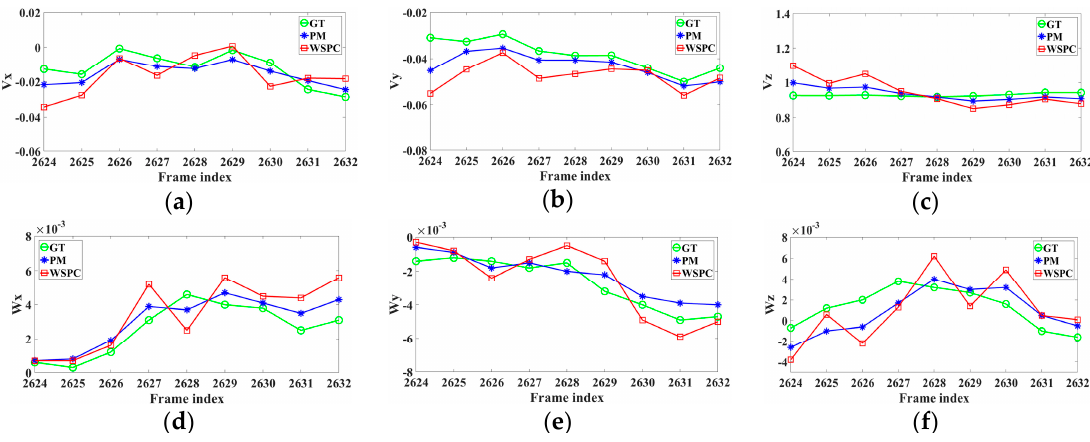
Figure 5. The results of ego-motion parameter estimation in scenario 1. ( a ) V x ; ( b ) V y ; ( c ) V z ; ( d ) W x ; ( e ) W y ; ( f ) W z .